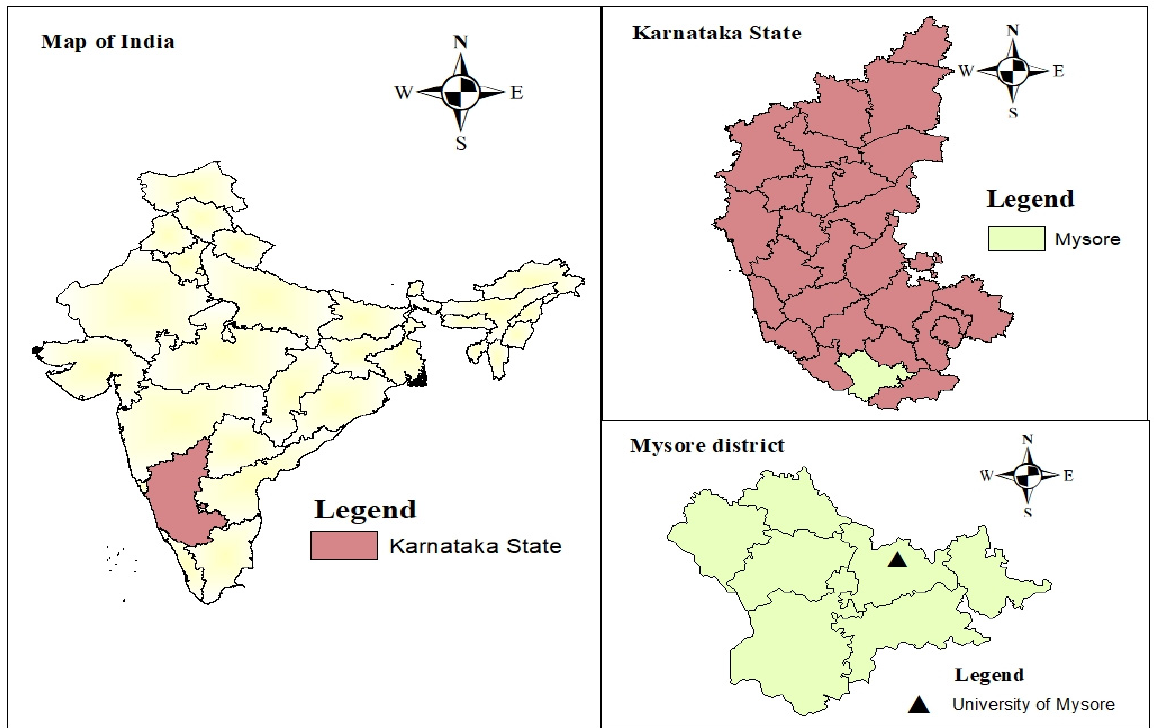
Figure 1. Geographical location of the study area.